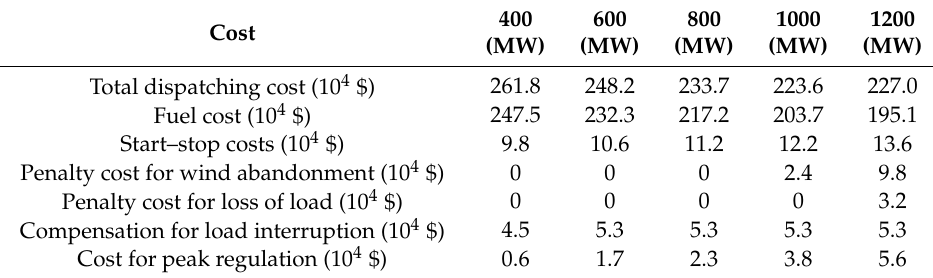
Table 3. Operational indicators under di ff erent wind power